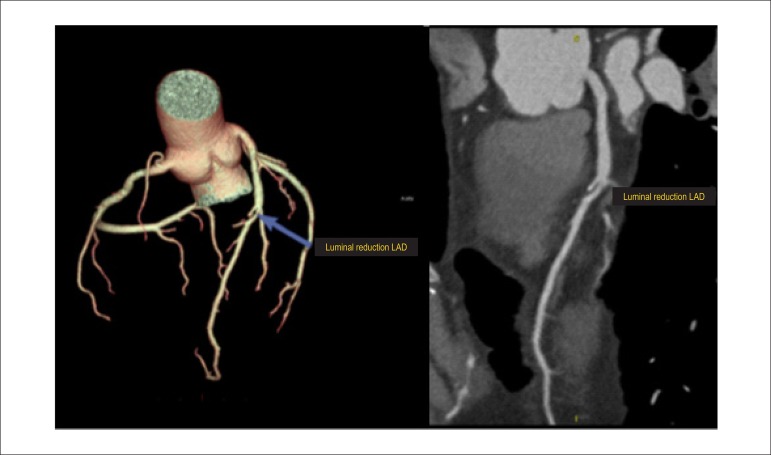
Case 9 - Angio-CT demonstrating significant obstructive luminal lesion, with the absence of calcification in coronary arteries. LAD left anterior descending artery.